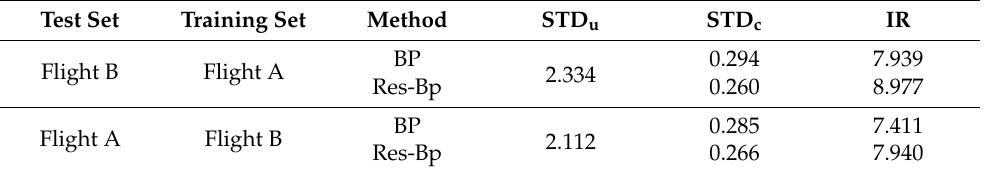
Table 2. Comparison of compensation results of BP and Res-Bp.